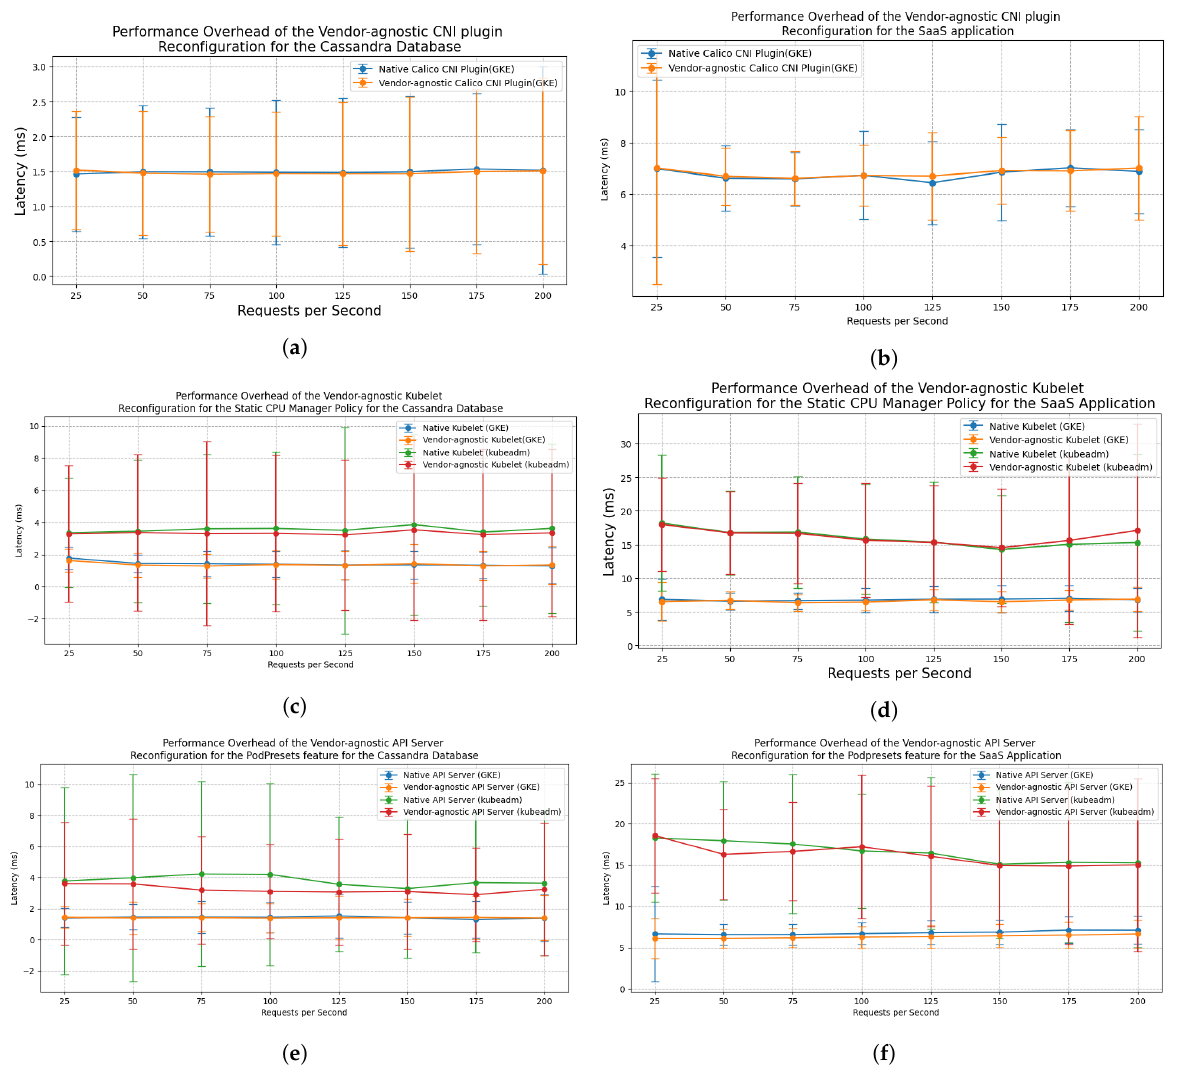
Figure 9. Performance overhead of the three Reconfigurator modules of the autonomic controller in comparison with native configuration using proprietary customization interfaces of two K8s vendors (GKE and kubeadm). An explanation for each subfigure ( a – f ) is given above